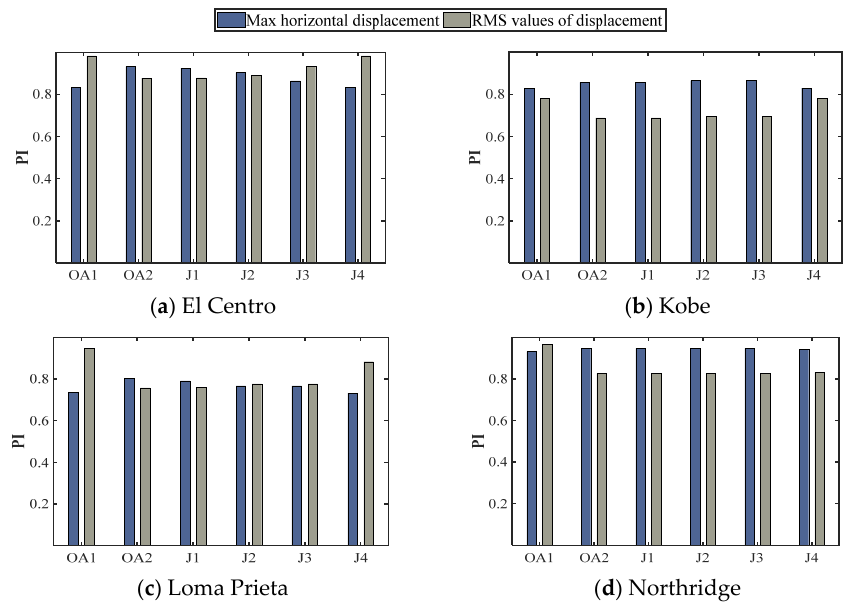
Figure 11. PI values for every optimization approach using TMDs with μ = 0.02.